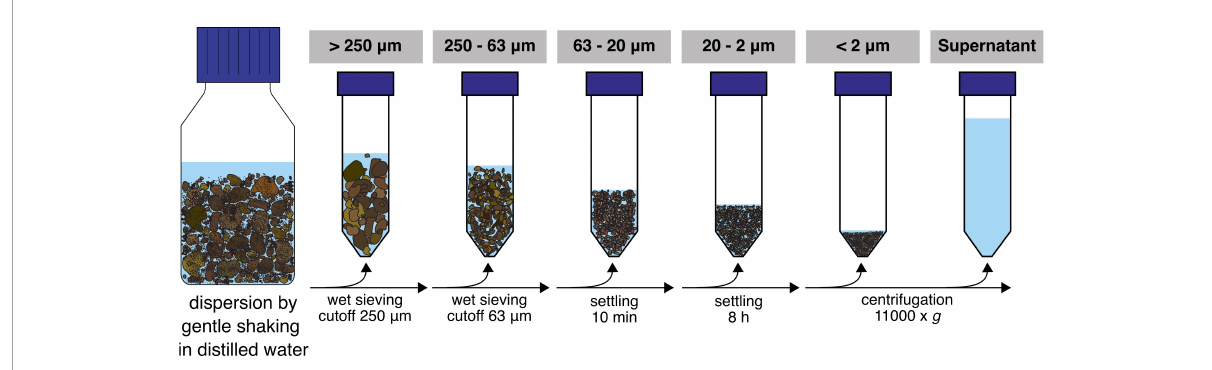
FIGURE1 Schematic representation of the gentle soil fractionation procedure applied in the